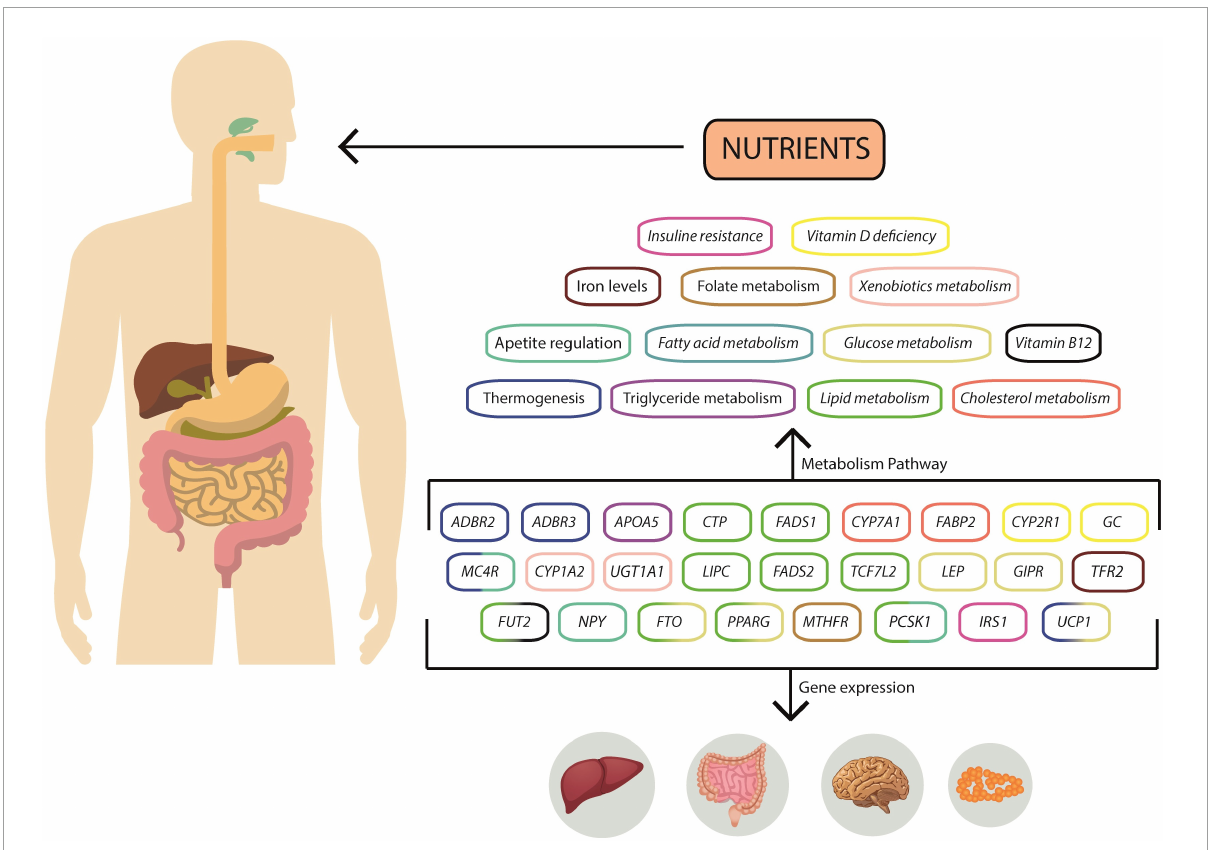
FIGURE2 Overview of gene interactions and gene expression in nutritional metabolism pathways. Diet can influence gene expression in several ways, and nutrients can be metabolized through various pathways, altering the concentration of substrates or intermediates that influence gene expression. Changes in gene expression can impact the liver, hypothalamus, and adipose tissue. These nutrient-gene interactions can be detrimental, increasing the risk of